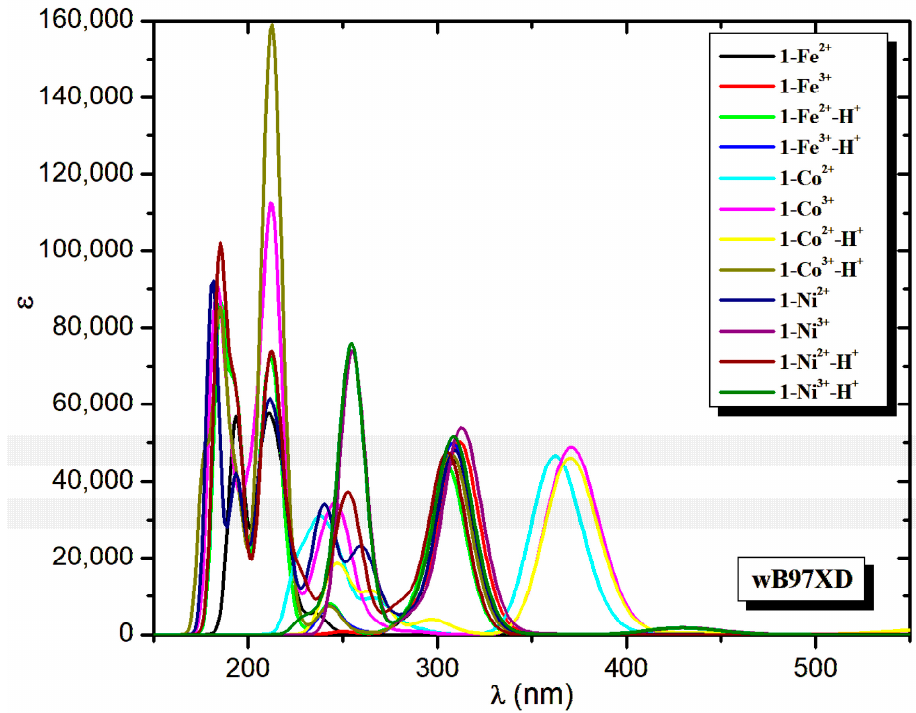
Figure 4. Absorption spectra of the calculated minima at wB97XD/6-31G(d,p) in THF solvent.